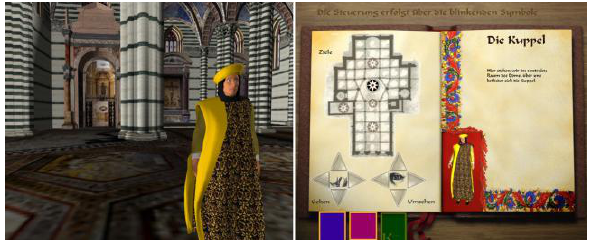
Figure 9.The famous Digital Cathedral of Siena (cf. Behr et al., 2001): the left image shows the rendered 3D view of